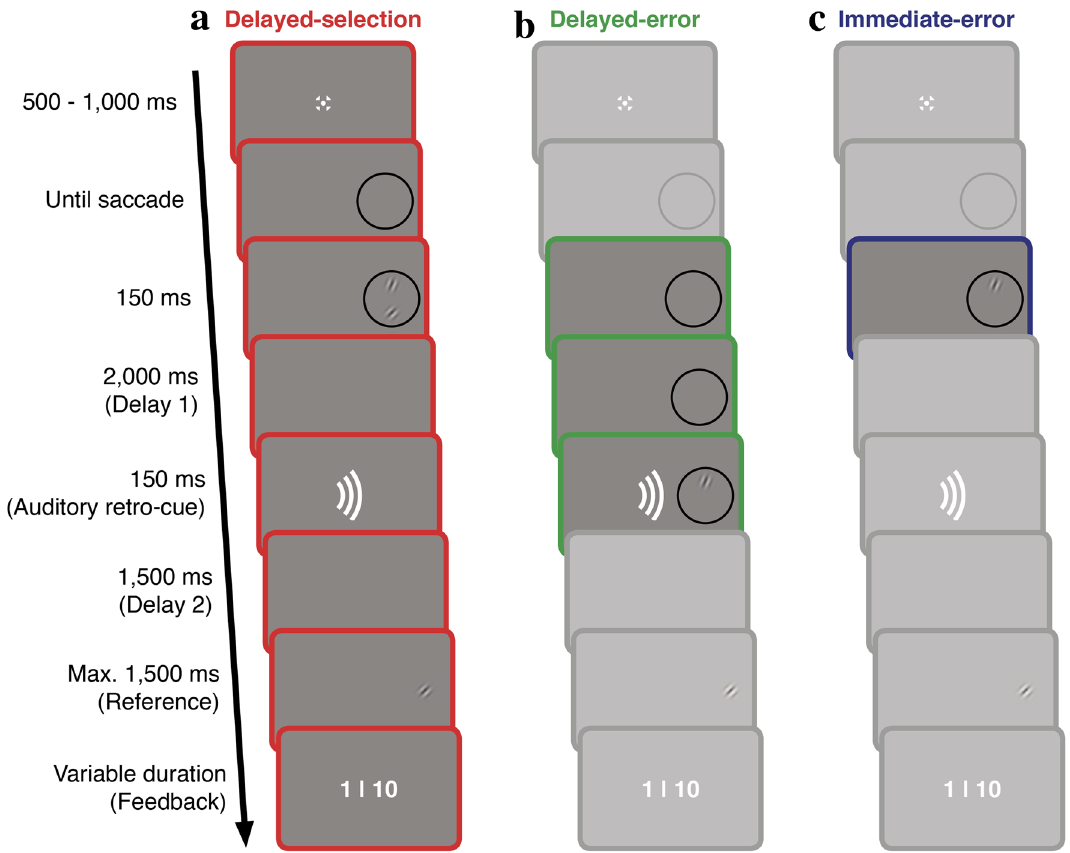
Figure 1. Trial procedure. ( a ) In the delayed-selection condition, participants were instructed to saccade to an otherwise irrelevant eye movement target (black ring), which always appeared 10° to the right of the fixation cross. During the saccade, two stimuli (Gabor patches) were shown within the eye movement target. After delay 1, one of the two stimuli was cued as being task-relevant by an auditory retro-cue. Thus, the task-relevant stimulus in this condition always corresponds to the one out of two shown stimuli, signaled by the retro-cue as being relevant for the comparison task of our paradigm. After delay 2, a reference (Gabor patch) was shown and participants had to judge if the orientation of the reference matched the orientation of the task-relevant (i.e., cued) stimulus. Participants received feedback about their judgement at the end of a trial. ( b ) In the delayed- error condition, only one task-relevant stimulus was shown after delay 1. ( c ) In the immediate-error condition, only one task-relevant stimulus was shown immediately after the saccade. ( b , c ) In the latter two conditions, since only one stimulus was shown before reference onset, this singular stimulus was automatically the task- relevant stimulus that had to be compared to the reference. Differences in the trial procedure relative to the delayed-selection condition are highlighted. ( a – c ) Participants were allowed to look around freely during delays and were not required to maintain fixation. The screen remained empty during both delays, except for the delayed-error condition, in which we showed the ring throughout delay 1. Stimuli are not drawn to